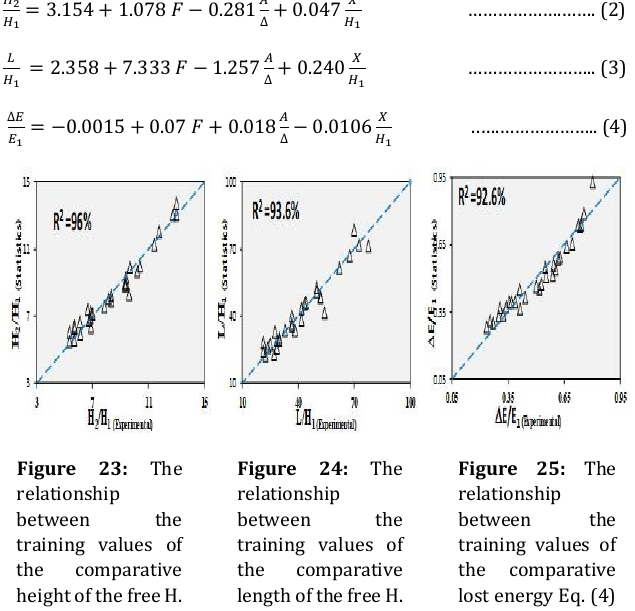
Figure Figure Figure 19: The